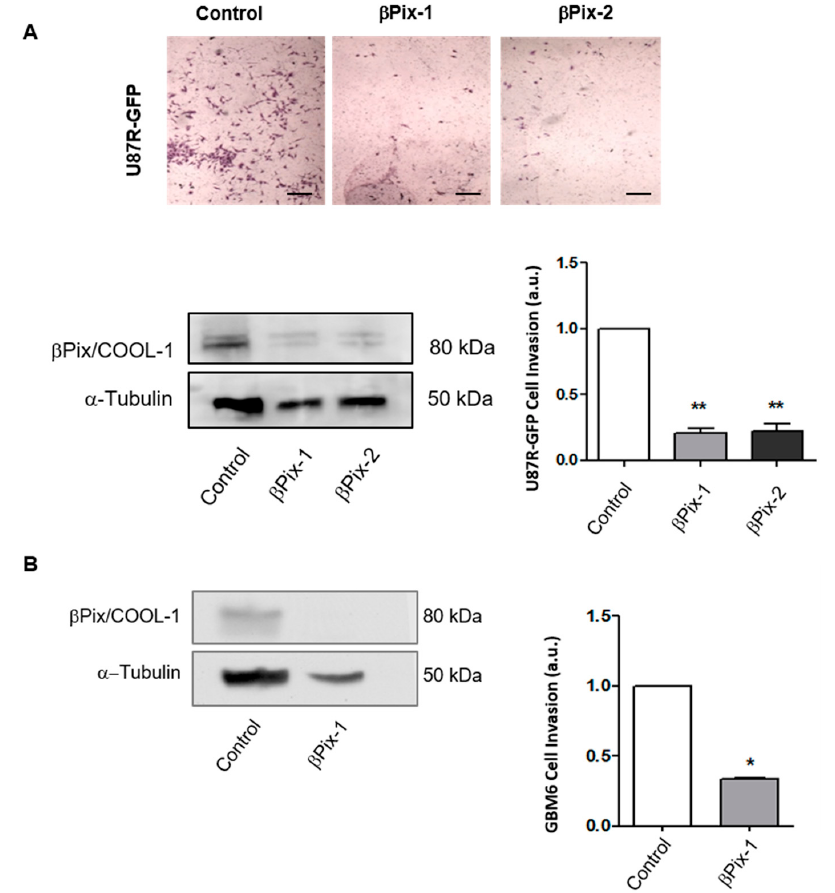
Figure 2. β Pix / COOL-1 depletion inhibits cell invasion in two GBM cell lines. ( A ) The e ff ect of Figure 2. β Pix/COOL-1 depletion inhibits cell invasion in two GBM cell lines. ( A ) The effect of beta- Pix knockdown using β Pix-1 and β Pix-2 siRNA duplexes (5 nM concentration) on GBM cell invasion